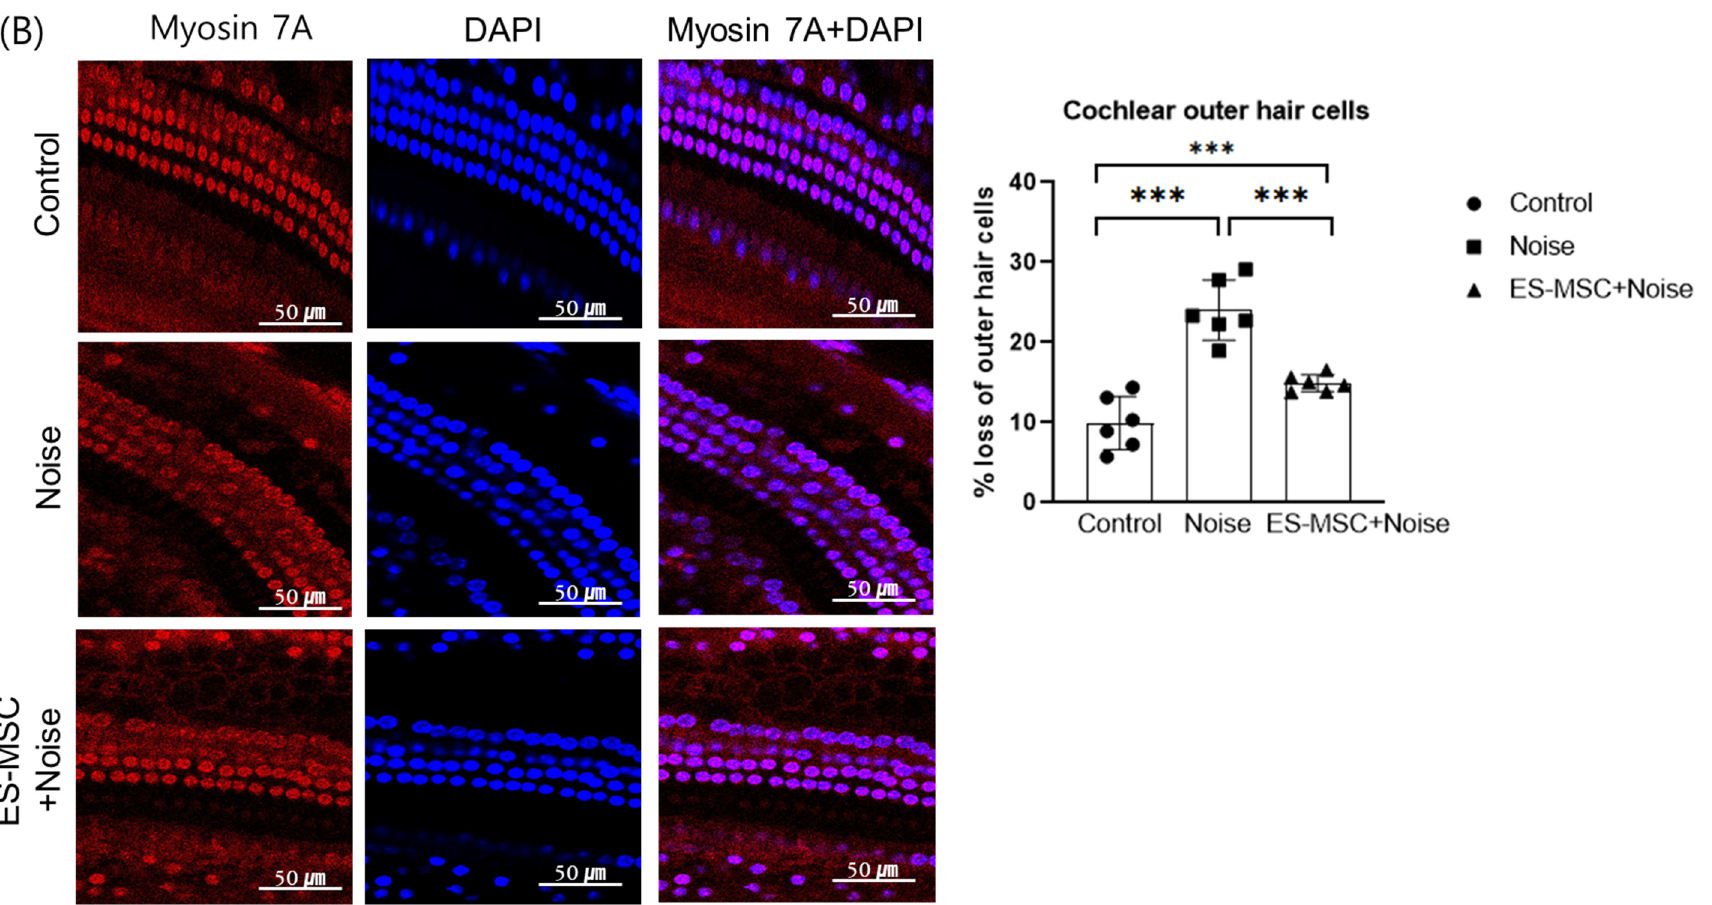
Figure 3. Cochlear histologic findings of the cochleae of control, noise, and ES-MSC+noise rats. ( A ) H&E staining (3 cochleae for each group) demonstrated a greater number of spiral ganglial cells in the ES-MSC+noise rats than in the noise rats which demonstrated gross loss of spiral ganglial cells ( B ) Cochlear whole-mount examinations (6 cochleae for each group) demonstrated a lower proportion of loss of outer hair cells in the ES-MSC+noise rats than in the noise rats. The outer hair cell counts in the middle turn of the cochleae demonstrated lower loss of outer hair cells in the ES-MSC+noise rats than in the noise rats (*** p < 0.01, scale bar: (A) 250 µm, 200 µm, 100 µm, (B) 50 µm). To test the possible transplantation and regeneration of injured cochlea by the injected ES-MSCs, the distributions of injected ES-MSCs were explored using human gene ( sry ) PCR in the cochlea, lung, liver, and spleen (Figure 4). Sry bands were detected in